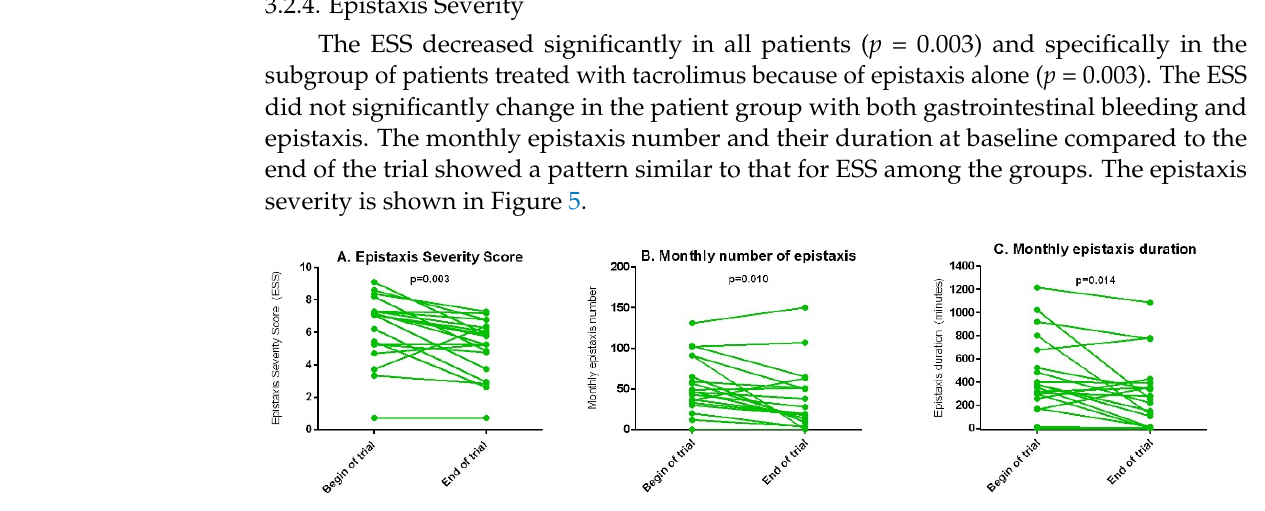
Figure 5. Epistaxis severity measurements at baseline and at the end of the trial. ( A ) Epistaxis Severity Score. ( B ) Number of epistaxis events monthly. ( C ) Monthly epistaxis duration in minutes.